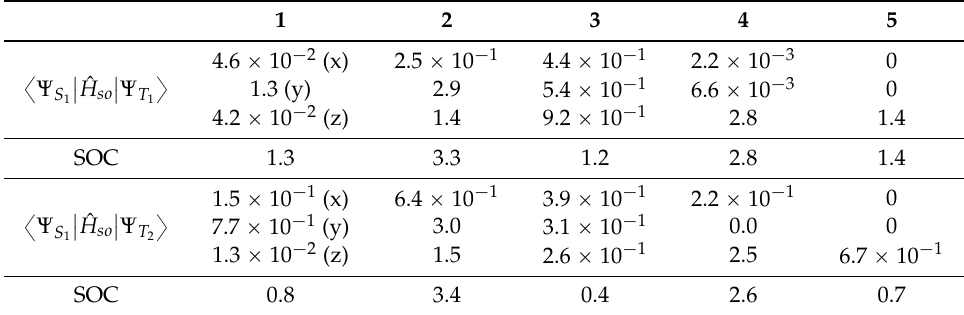
Table 2. Spin-orbit coupling Cartesian components and correspondent spin-orbit couplings (SOC) (cm ´ 1 ) between low-lying singlet and triplet excited states calculated at B3LYP/cc-pVDZ//B3LYP/ 6-31G* level of